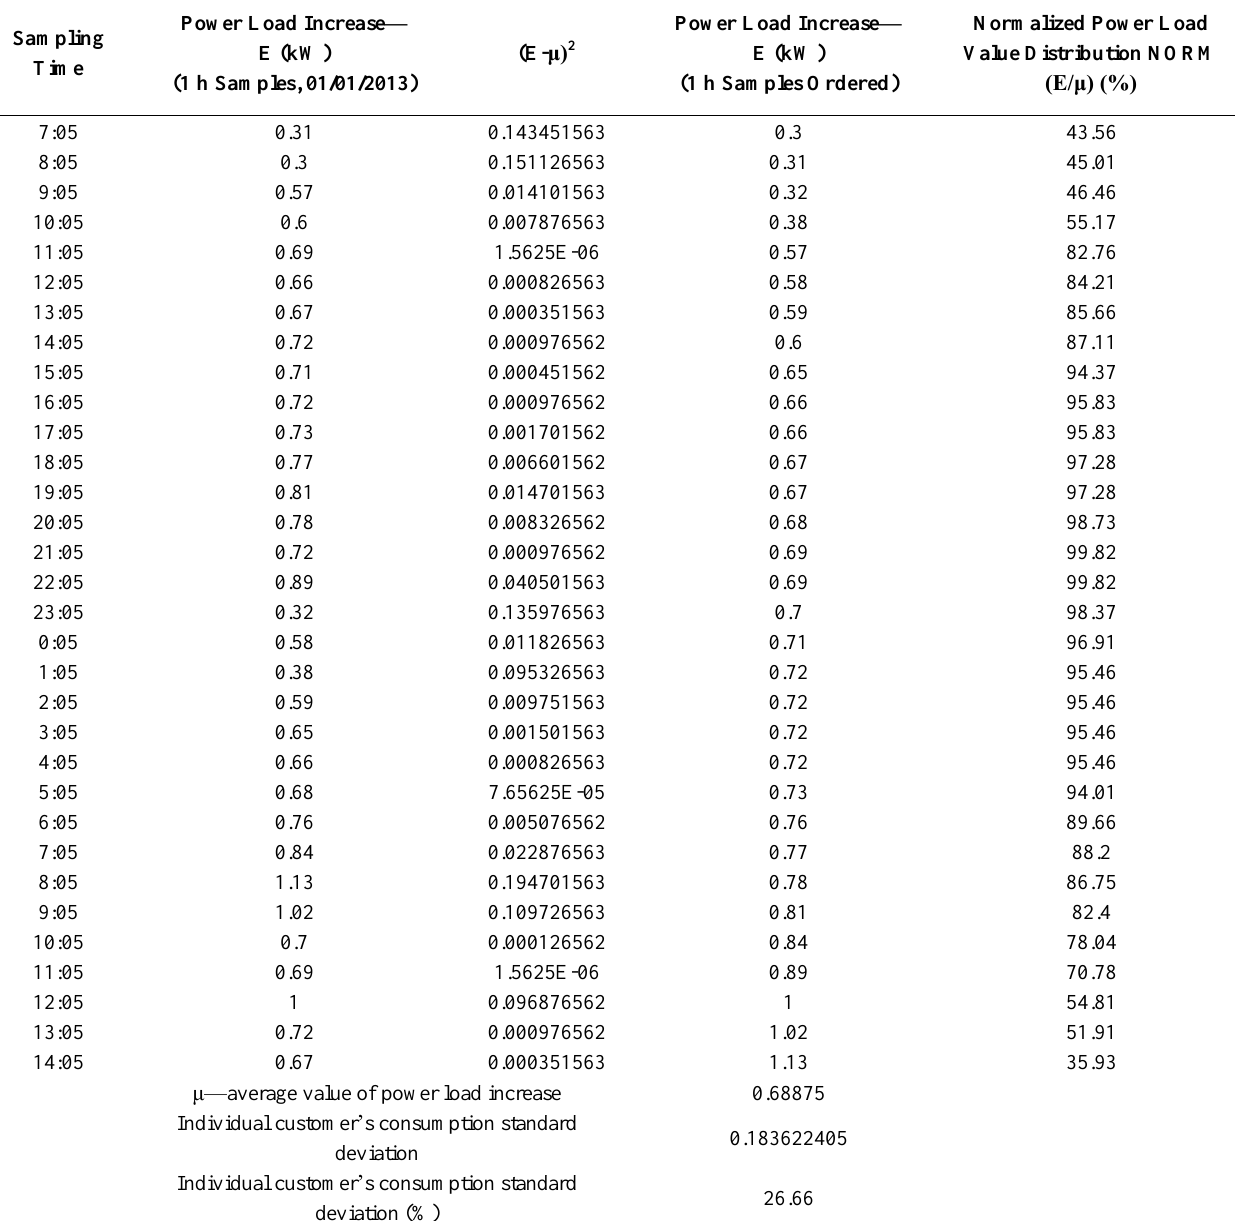
Table 1. Verification of electric values distribution model—source: ED Jugoistok Niš.